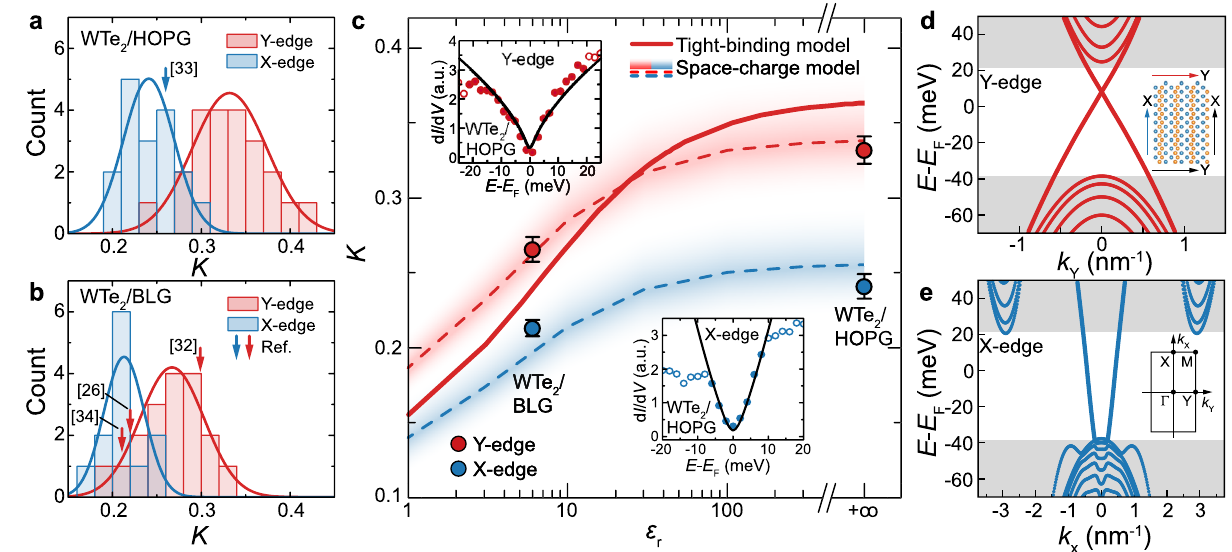
Fig.3|DielectricscreeningoftheTLLmany-bodyinteractions.a , b Histograms of the Luttinger parameter K , recorded across 69 locations along the X- and Y-edges of WTe 2 /HOPG and WTe 2 /BLG islands. Solid lines are fi ts to Gaussian normal distributions characterised to extract statistical mean and standard deviation.Arrowsindicatedatapointsfromliterature 26,33--35 . c Luttingerparameter K , extracted across different samples, and literature, plotted as a function of the substratedielectricconstant ϵ r .Red(blue)circlesare themeanand standarderror of themeanextractedforthe distributionsin a , b . Shadedbandsand dashed lines arenumericalcalculationsof K basedontheelectrostaticenergy W ( q =0)storedin a screened edge charge distribution of varying density (see text), as well as the calculated edge dependent Fermi velocity v F extracted from d and e . The bands have been modeled to coincide in width with the extracted standard deviation of